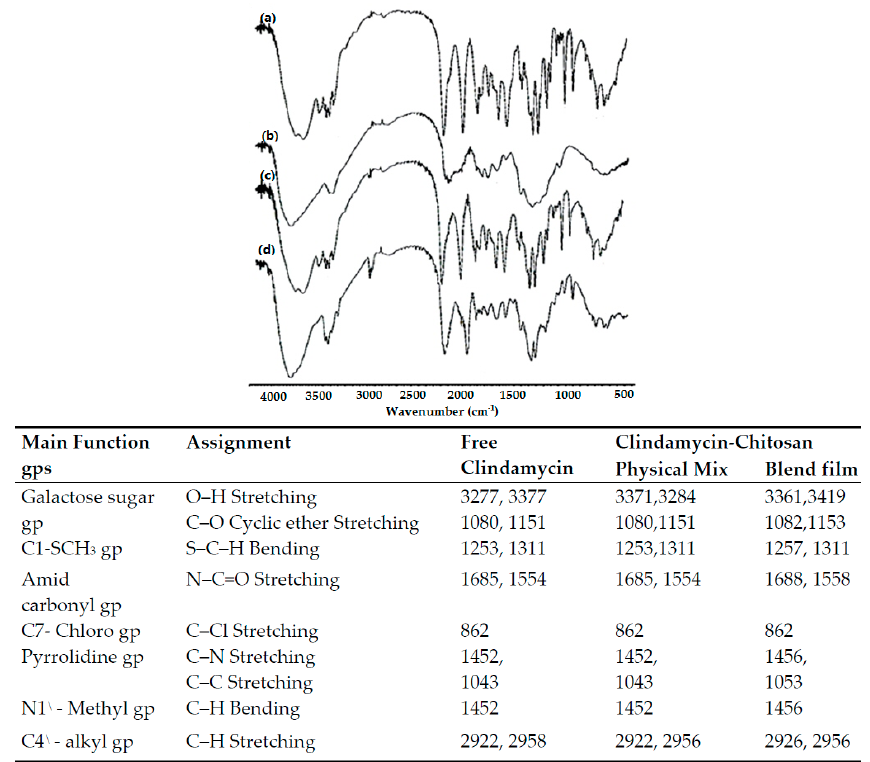
Figure 10. Most effective FTIR bands and spectra of: (a) pure clindamycin; (b) chitosan alone; (c) clindamycin-chitosan physical mixture; (d) clindamycin-chitosan blend film.